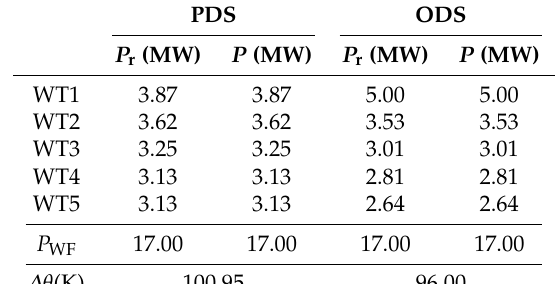
Table 4. Comparison of power and temperature rise in Case 3, M1.